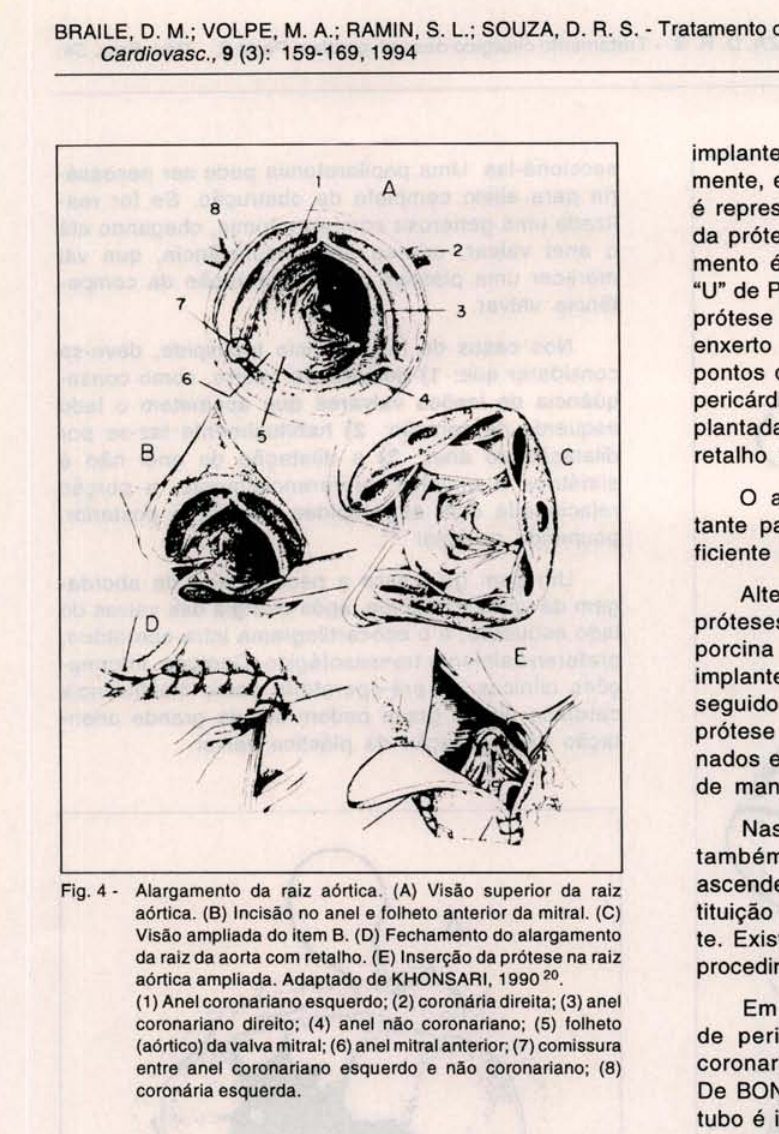
Fig. 4 - Alargamento da raiz aórtica. (A) Visão superior da raiz aórtica. (8) Incisão no anel e folheto anterior da mitral. (C) Visão ampliada do item 8. (D) Fechamento do alargamento da raiz da aorta com retalho. (E) Inserção da prótese na raiz aórtica ampliada. Adaptado de KHONSARI, 1990 2 0. (1) Anel coronariano esquerdo; (2) coronária direita; (3) anel coronariano direito; (4) anel não coronariano; (5) folheto (aórtico) da valva mitral; (6) anel mitral anterior; (7)